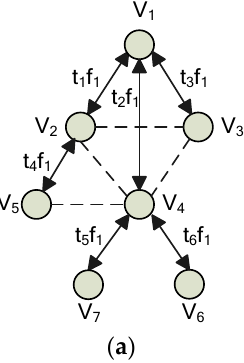
Figure 3. Single channel and multi-channel scheduling. ( a ) Single channel, ( b ) Three channels.